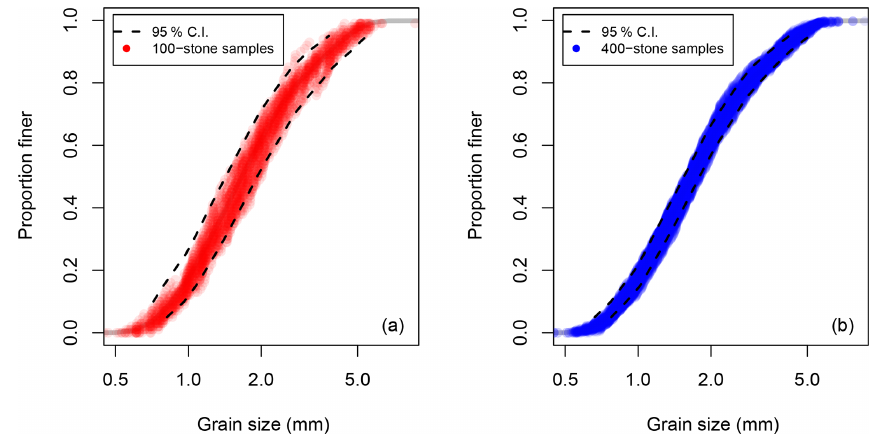
Figure 5. Effect of sample size on uncertainty. In panel (a) , 25 samples of 100 stones drawn from a known population are plotted along with the 95% grain size confidence interval calculated for D 5 to D 95 using the binomial method. In panel (b) samples of 400 stones are plotted along with the predicted grain size confidence interval.